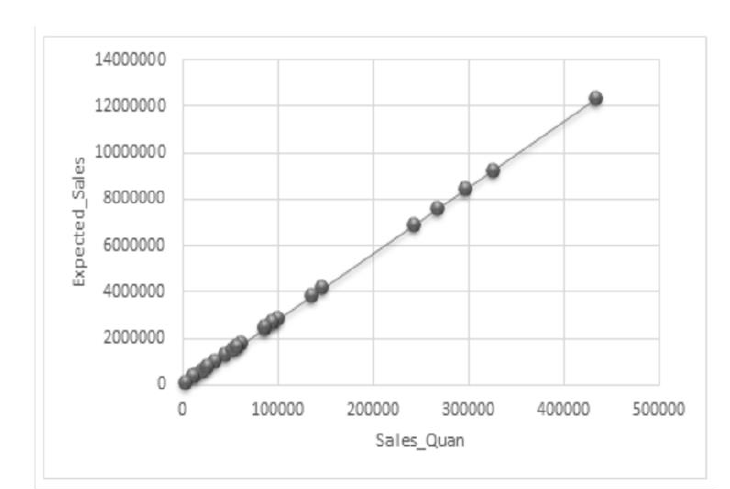
Figure 4: Scatter plot after